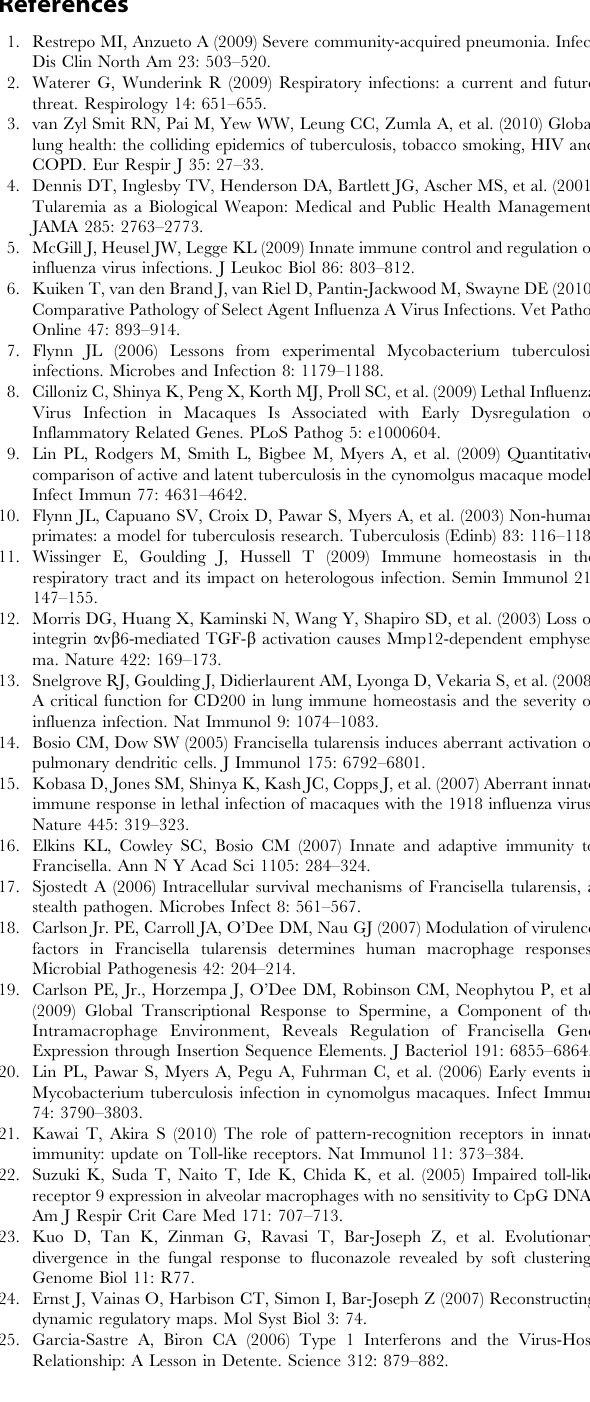
Table S3 Expression values of DE genes from Murine arrays. Values are log 2 transformed and represent the fold change from time =